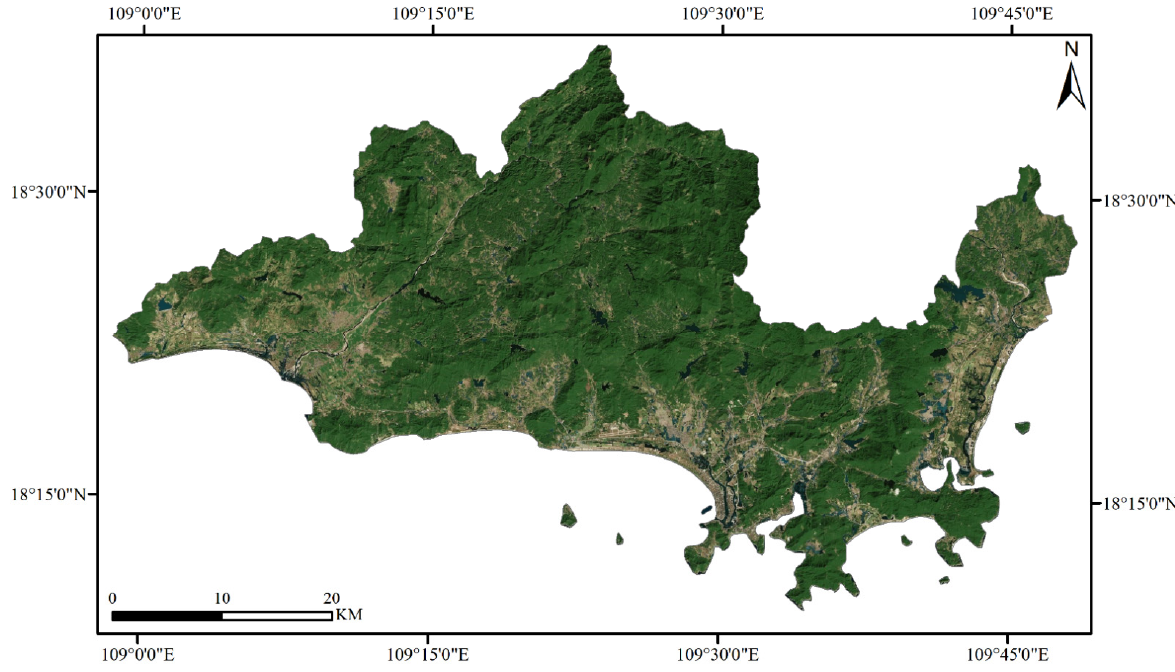
Figure 1. Remote sensing image of Sanya city.